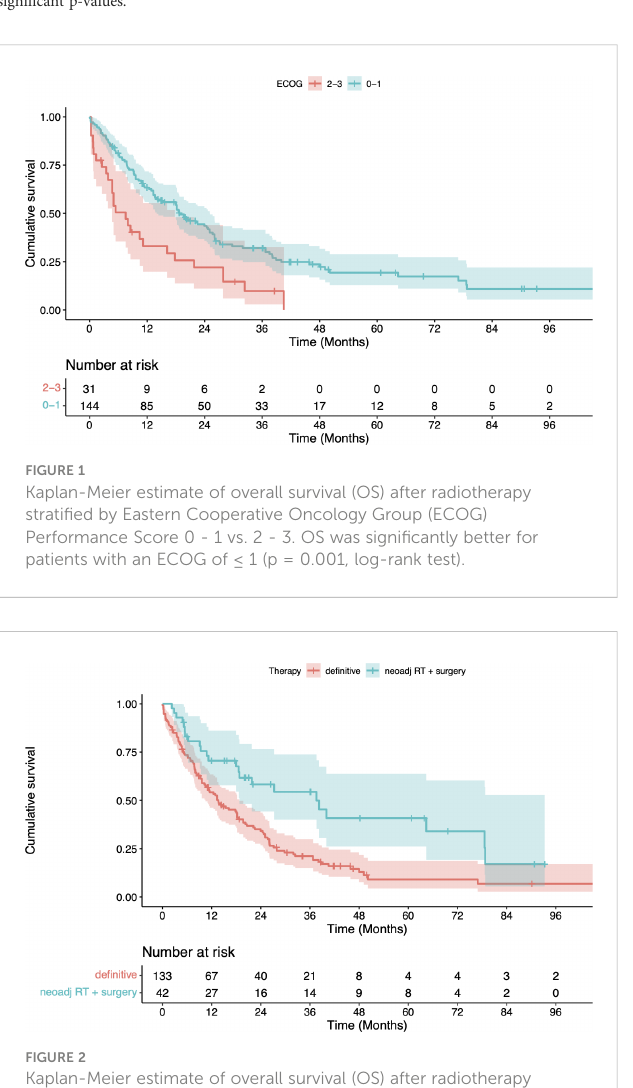
FIGURE 2 Kaplan-Meier estimate of overall survival (OS) after radiotherapy strati fi ed by scheduled application of chemotherapy vs. no or modi fi ed administration of chemotherapy. OS was signi fi cantly better for patients with a scheduled application of chemotherapy (p < 0.001, log-rank test).